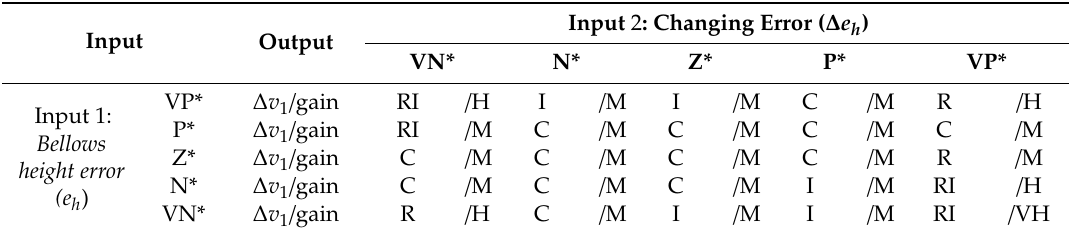
Table 3. Adaptive fuzzy rules under 50% of the bellows progress to determine the compression speed adjustment ∆ v 1 and gain. (*Refer to Figure 12).